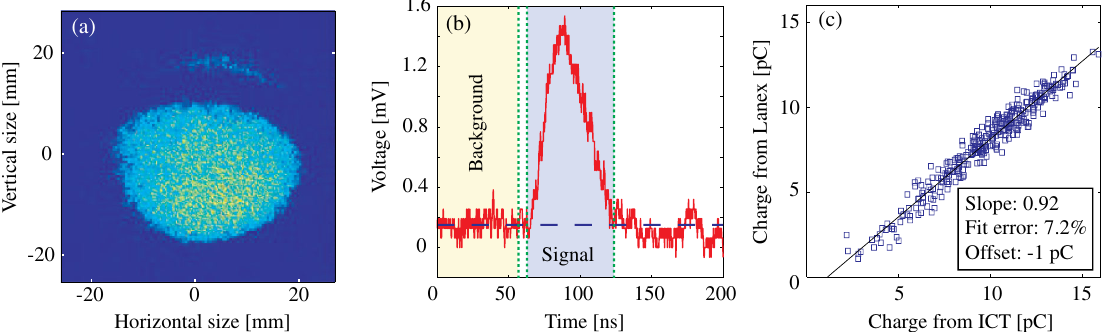
FIG. 10. (a) Typical measured e-beam profile with the Lanex. (b) Typical measured ICT signal (solid line). (c) Lanex measured charge as versus ICT measured charge. The solid line is a linear fit, and the slope and offset are shown in the inset as well as the fit error. The total counts on the CCD camera were biased based on the analysis in Sec. II B, and points with both SN 10 were taken into